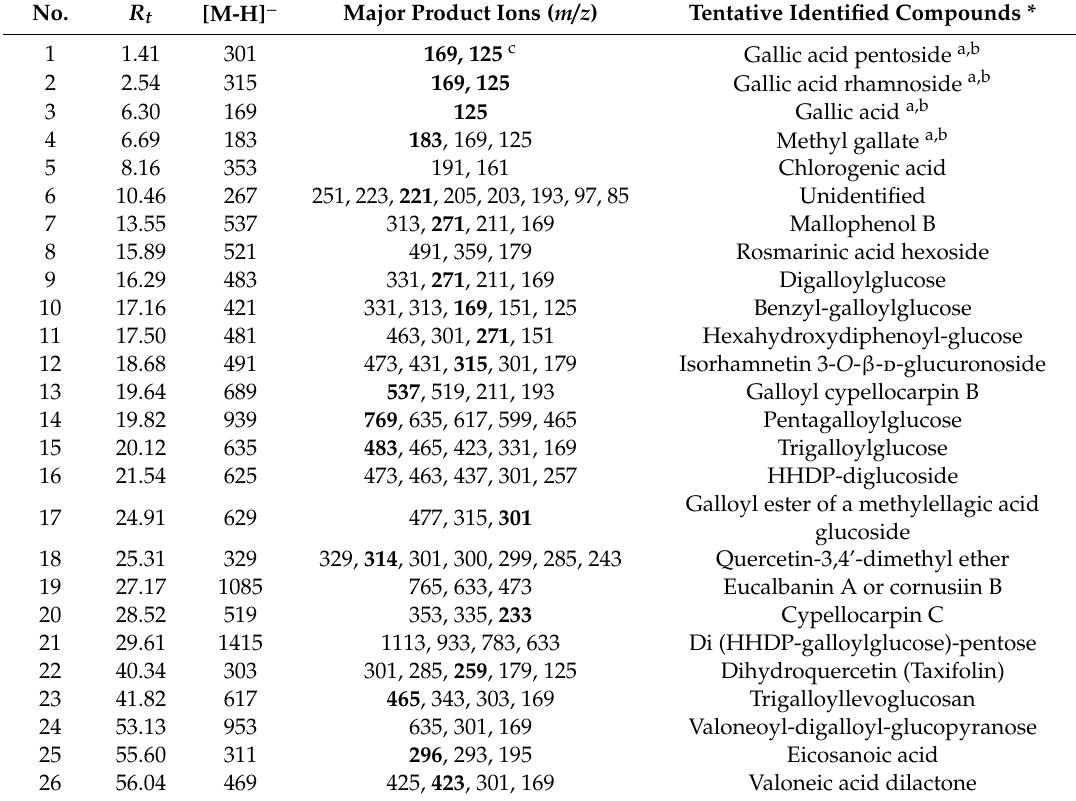
Figure 1. Out of the annotated compounds, 4 compounds were isolated and characterized based on their NMR data as (1) 4-( O - β - d -xylopyranosyloxy)-3,5-di-hydroxy-benzoic acid, (2) 4-( O - α - l - rhamnopyranosyloxy)-3,5-di-hydroxy-benzoic acid, (3) 3,4,5-trihydroxybenzoic acid (gallic acid), and (4) methyl 3,4,5-trihydroxybenzoate (methyl gallate) (Figure 2) (Supplementary data S2). Table 1. Phenolic compounds tentatively identified in the methanol extract of E. globulus (EG) leaves by HPLC-DAD-ESI-MS /